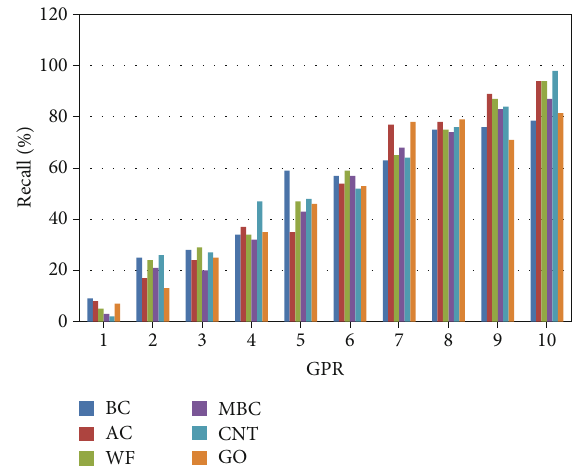
Figure 4: Recalls of